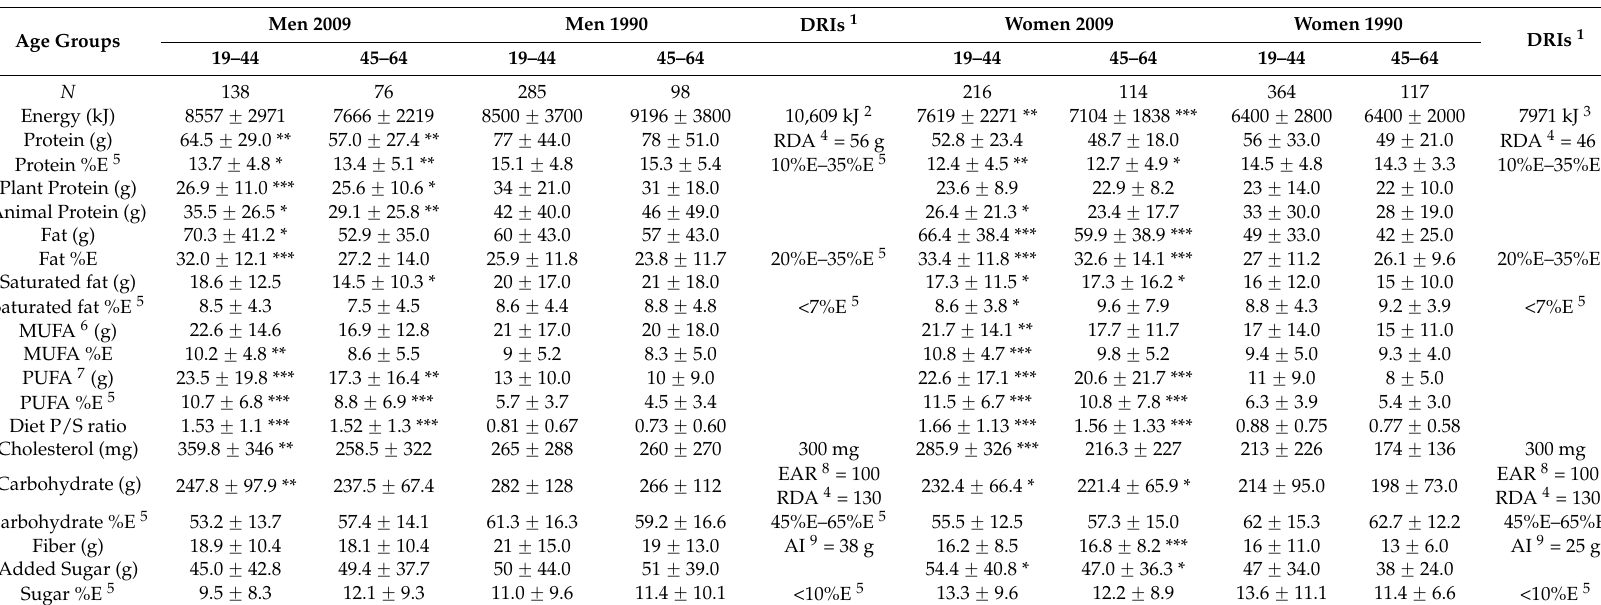
Table 1. Energy and macronutrient intakes of 19–64-year-old black adults in the Cardiovascular Risk in Black South Africans (CRIBSA) study (2009) in Cape Town and comparison with the Black Risk Factor (BRISK) 1990 study